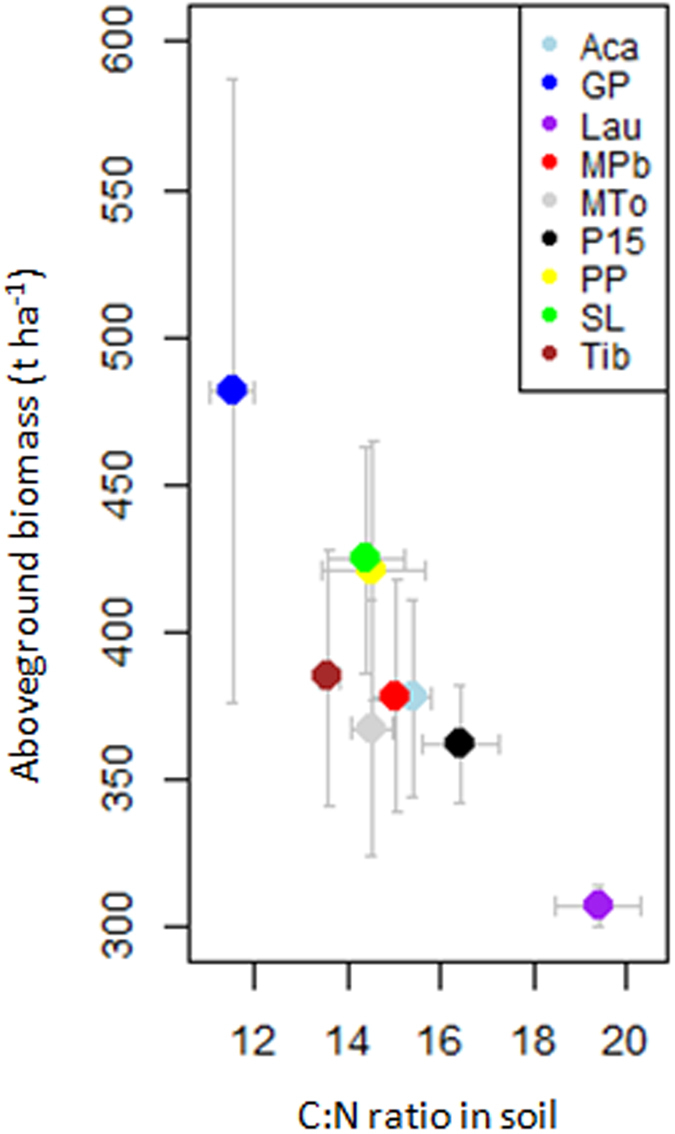
Aboveground biomass vs soil C:N ratio.Abbreviations in the legend are detailed in Table S1.